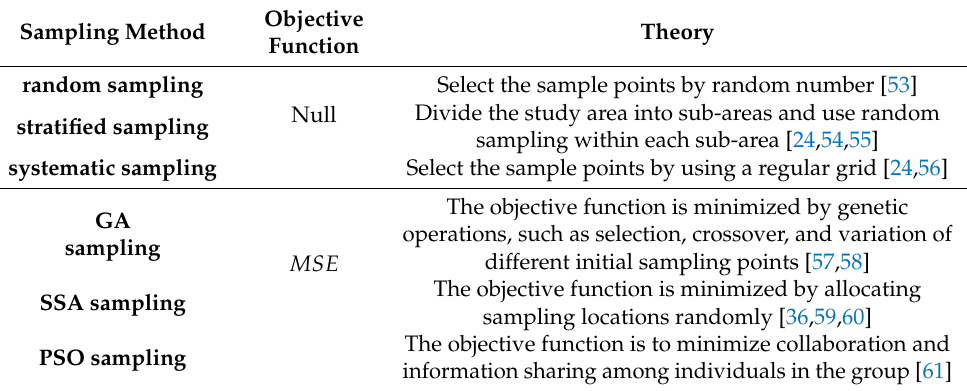
Table 3. Water single-parameter sampling design